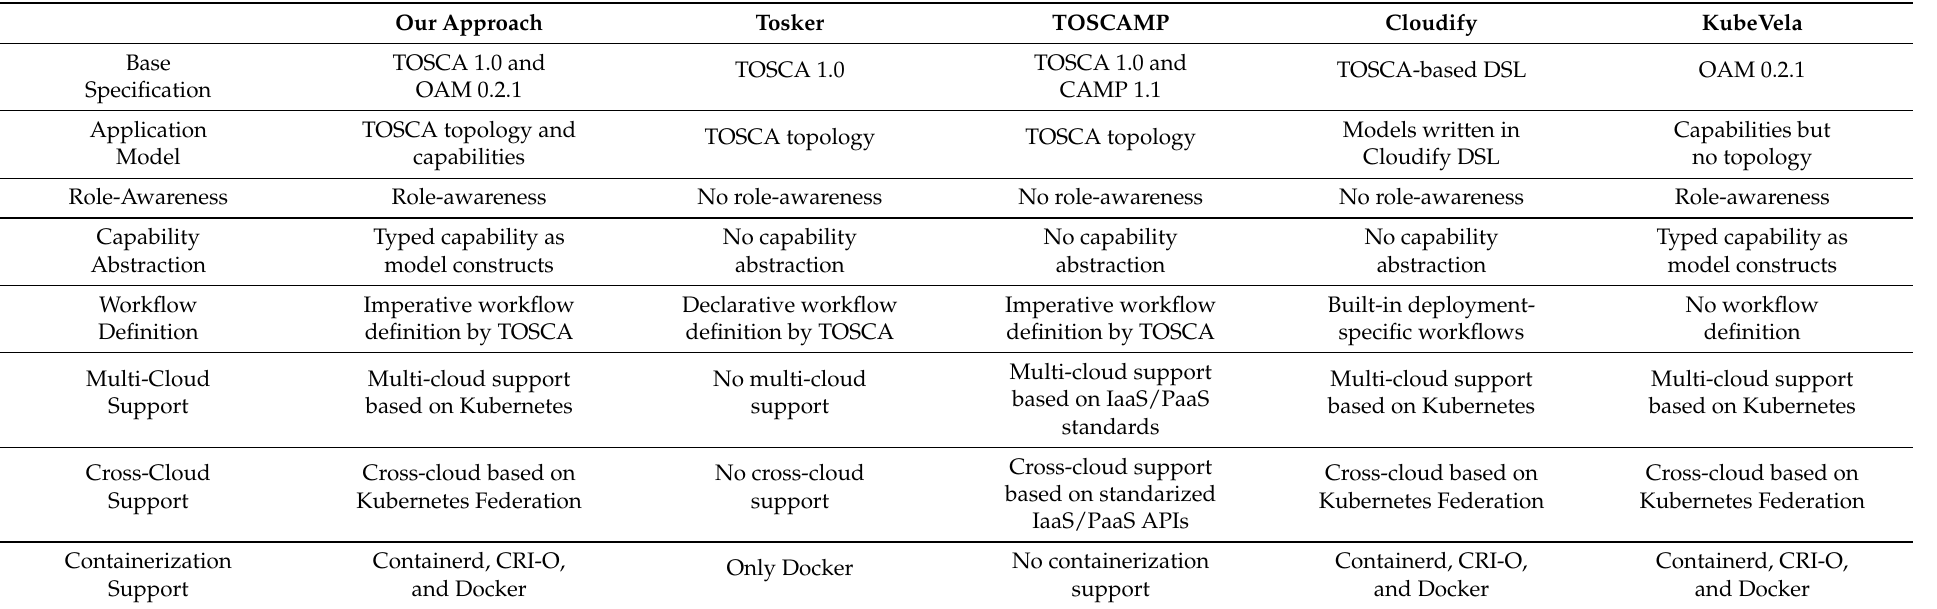
Table 3. Qualitative analysis of orchestration